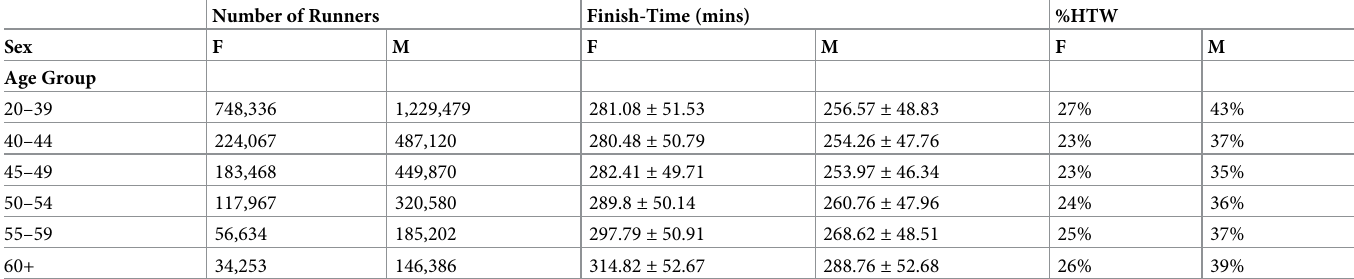
Table 2. An overall summary of the original dataset by age group, showing the number of male ( M ) and female ( F ) runners in each age group, with their average fin- ish-times, and the percentage of male and female runners deemed to have the wall, based on the definition adopted in this work. Number of